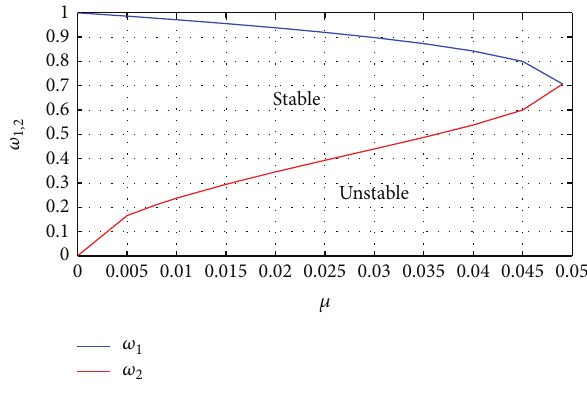
Figure 10: Correlation between 𝜇 and 𝜔 1,2 .